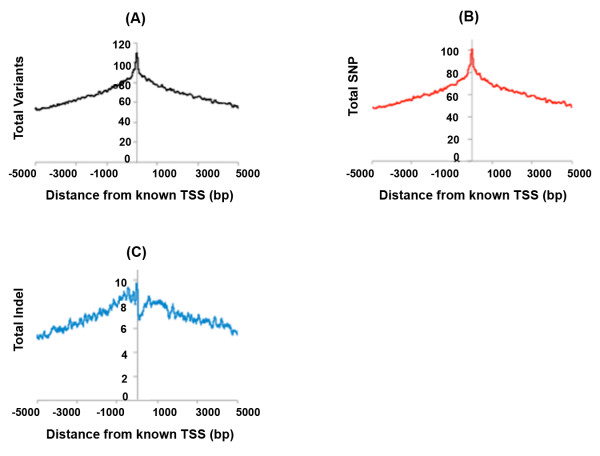
Average enrichment of variant around TSS of genes. (A) Average enrichment of all variants (SNPs + Indels) around TSS, (B) Average enrichment of SNPs around TSS, (C) Average enrichment of Indels around TSS.